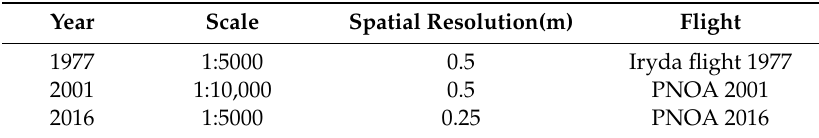
Table 1. Aerial orthophotos used [52], 2001 and 2016 orthophotos are from Plan Nacional de Ortofotograf í a A é rea (PNOA).